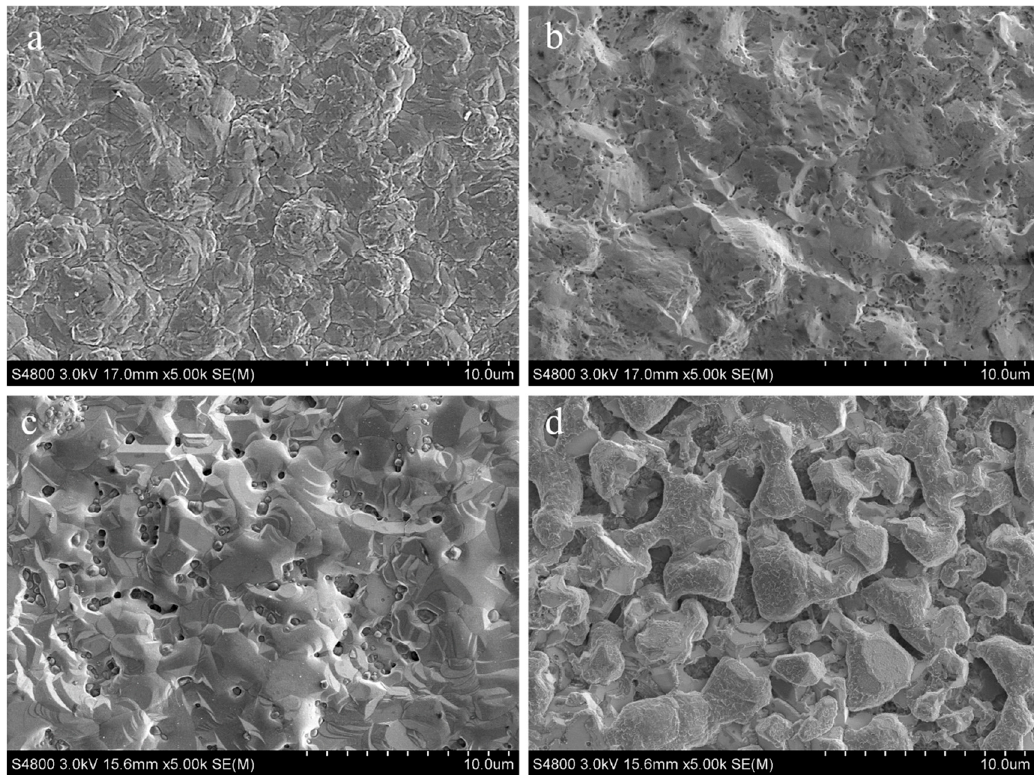
Figure 5. Surface morphology of the Ni/Cu/Ni coatings after annealing at various temperatures ( a ) untreated, ( b ) 600 °C, ( c ) 700 °C, ( d ) 800 °C, respectively.